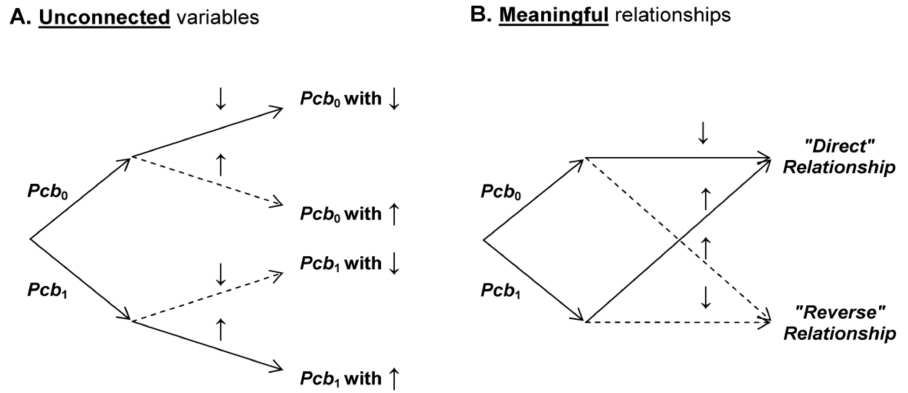
Figure 2. Unconnected variables vs. meaningful relationships. The two experimental conditions named Pcb 0 and Pcb 1 and the two system states ( ↓ , “resting” state; ↑ , “activated” state) are described either as unconnected variables ( A ) or as relationships (“direct” or “reverse”) meaningful for the experimenters ( B